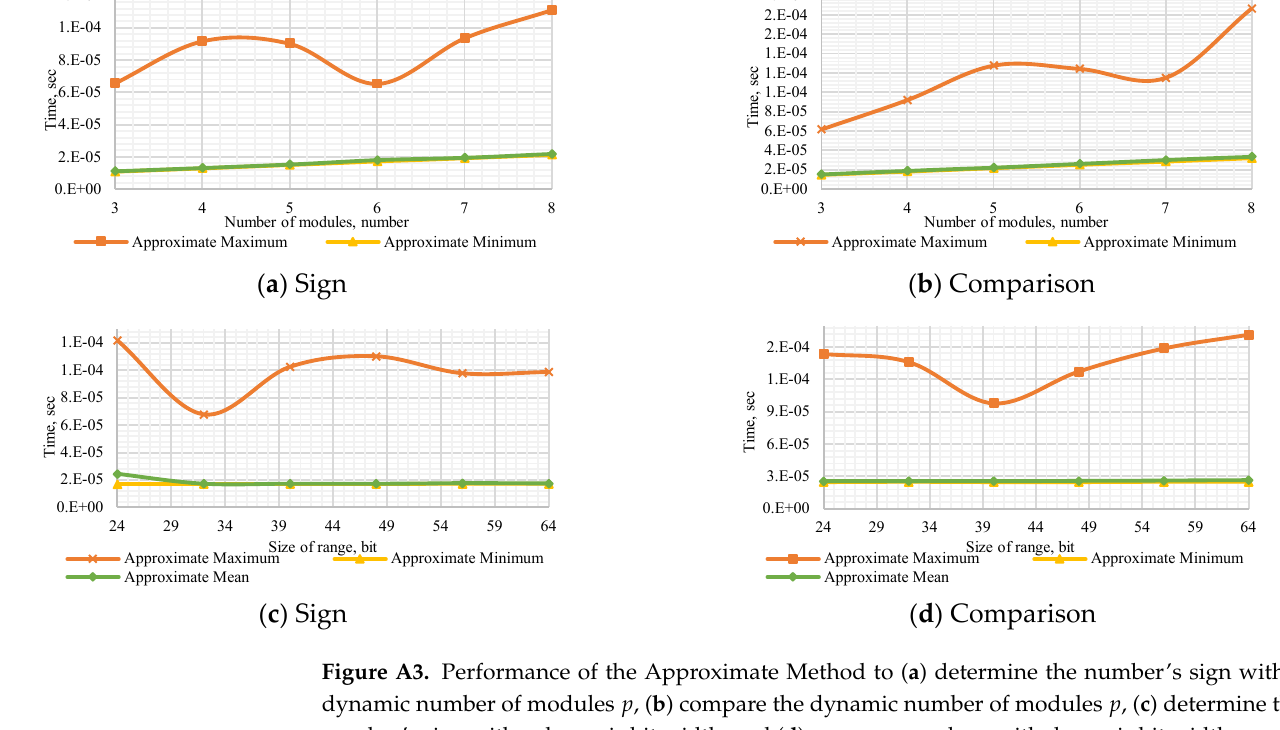
dynamic bit width, and ( d ) compare numbers with dynamic bit width.